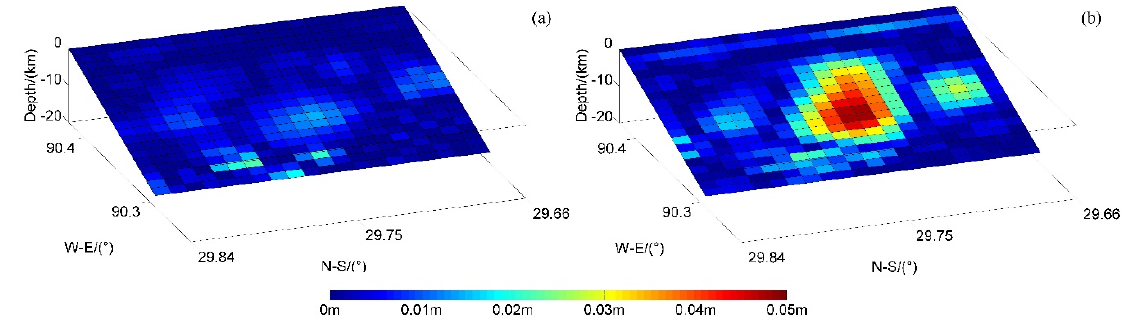
Figure 14. Difference of coseismic slip distribution. ( a ) Difference between HOT and LAT (Diff = HOT − LAT); ( b ) Difference between HET and LAT (Diff = HET − LAT).